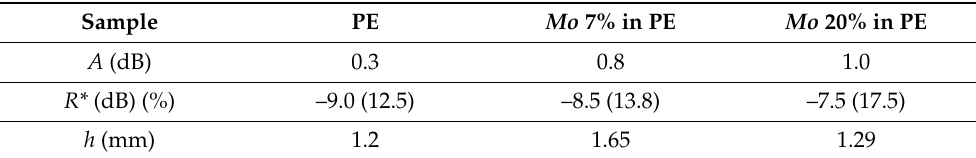
Table 14. Values of attenuation and reflection coefficients for molybdenum-containing nanocomposites at a frequency of 30 GHz.